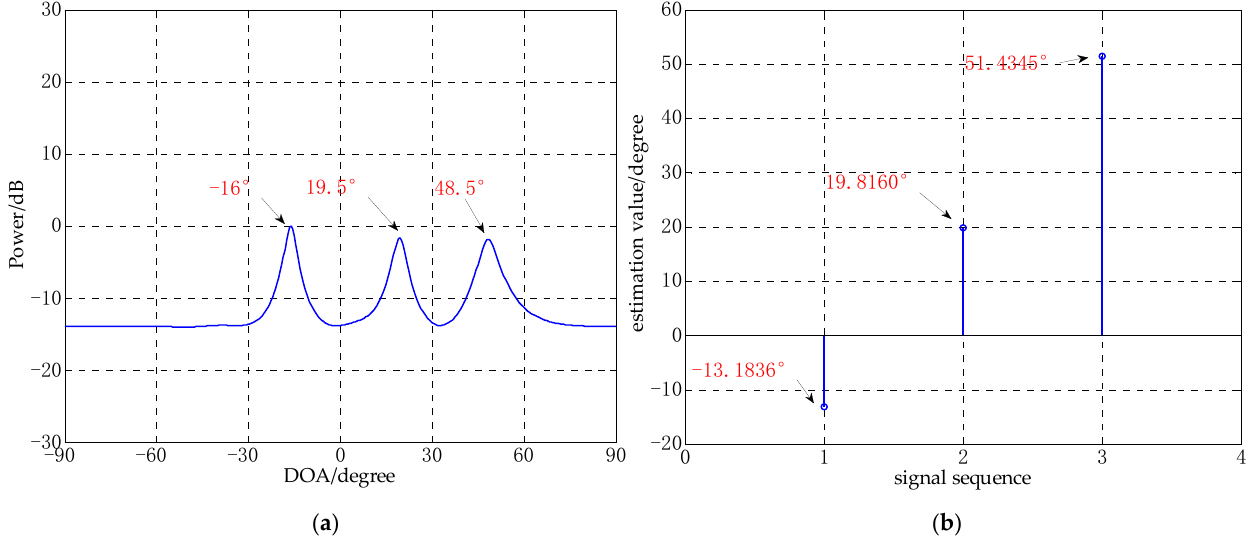
Figure 9. DOA estimation of MUSIC and TLS-ESPRIT (snapshots = 1000, SNR = − 10 dB). ( a ) MUSIC, ( b ) TLS-ESPRIT.